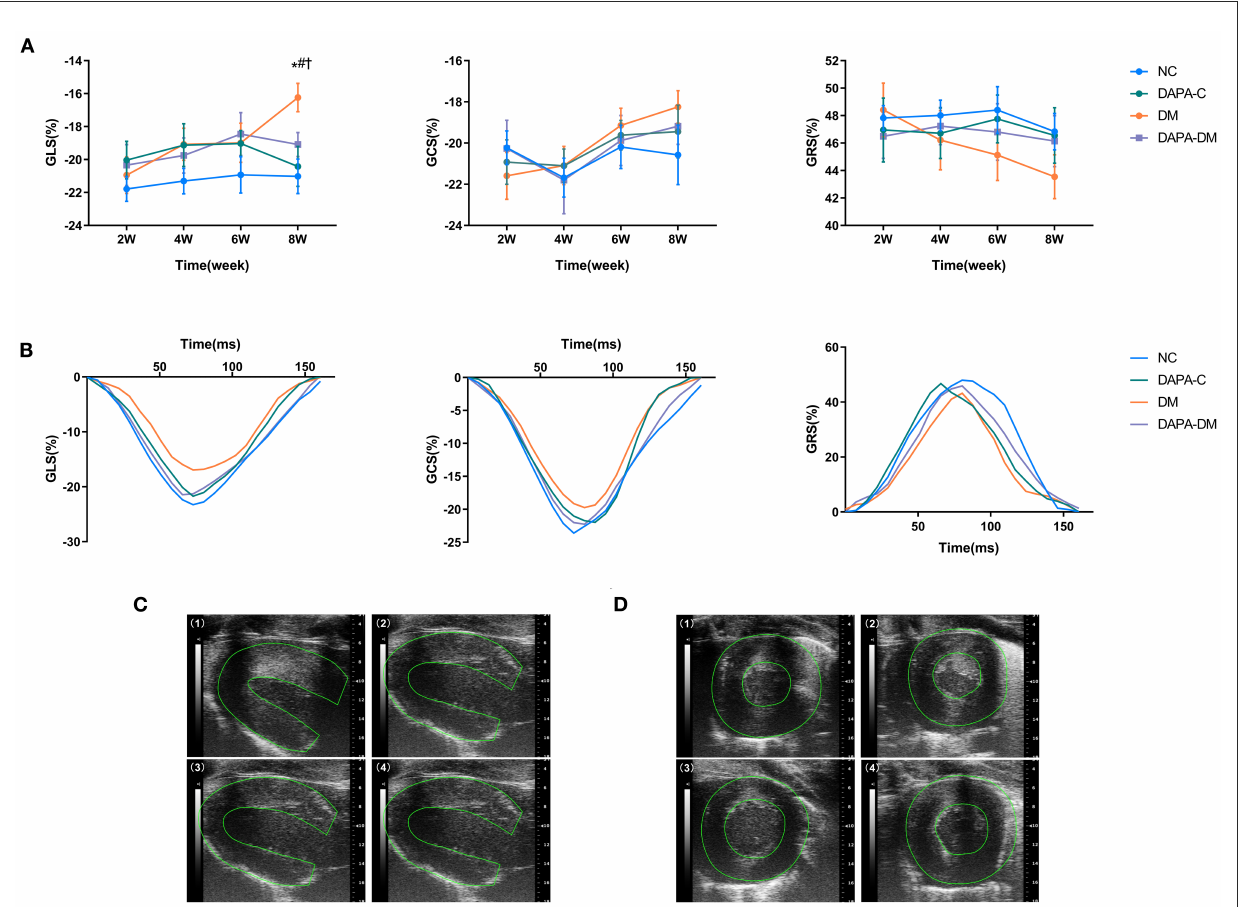
FIGURE3 Myocardial strain assessed by 2D-STE. (A) GLS, GRS and GCS scores of the four groups at different time points. (B) Representative strain time curves of the four groups. (C) Representative long-axis strain images of the four groups at 8 weeks. (D) Representative short-axis strain images of the four groups at 8 weeks. (1) normal control group, (2) DAPA-control group, (3) diabetic group, (4) DAPA-diabetic group. GLS, global peak longitudinal strain; GRS, global peak radial strain; GCS, global peak circumferential strain; NC, normal control group; DAPA-C, DAPA-control group; DM, diabetic group; DAPA-DM, DAPA-diabetic group. * p < 0.05 vs. normal control group; † p < 0.05 vs. DAPA-control group; # p < 0.05 vs. diabetic group at 2